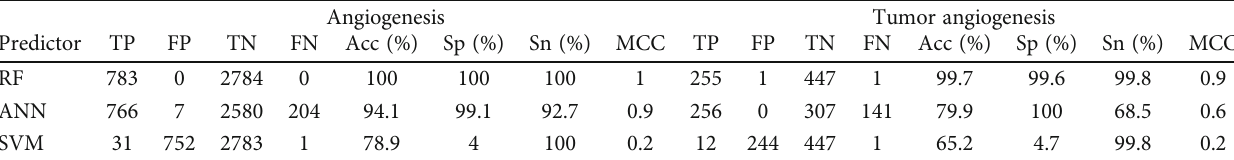
Table 2: Self-consistency results for angiogenesis and tumor angiogenesis.